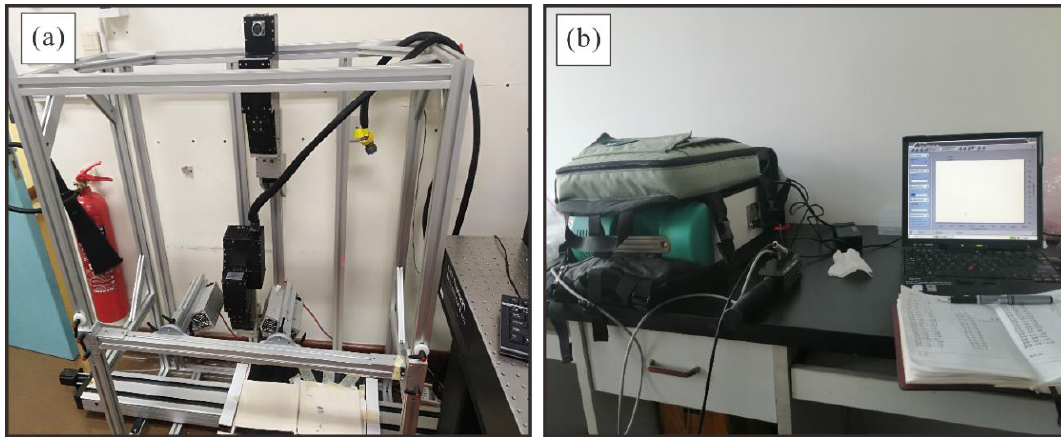
Figure 7. The instruments used for data acquisition in this paper: ( a ) HySpex hyperspectral imaging system and ( b ) Analytical Spectral Devices (ASD) FieldSpec-3 pro spectrometer.